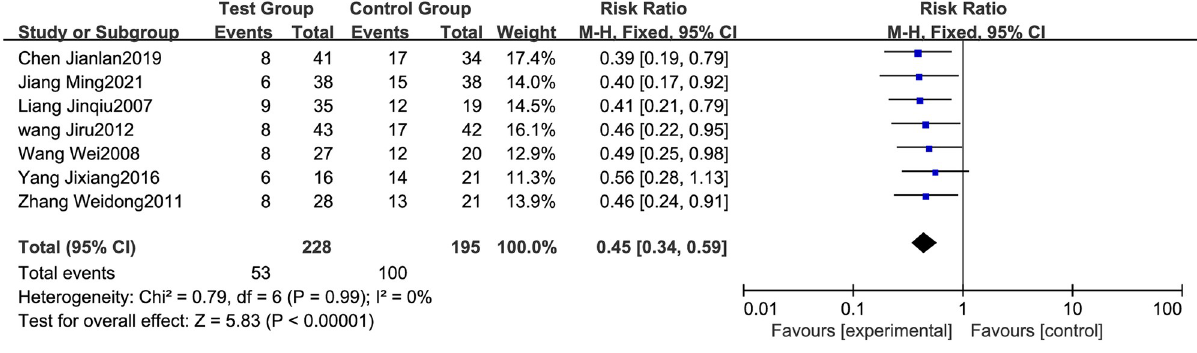
Fig 5. Forest plot of recurrence